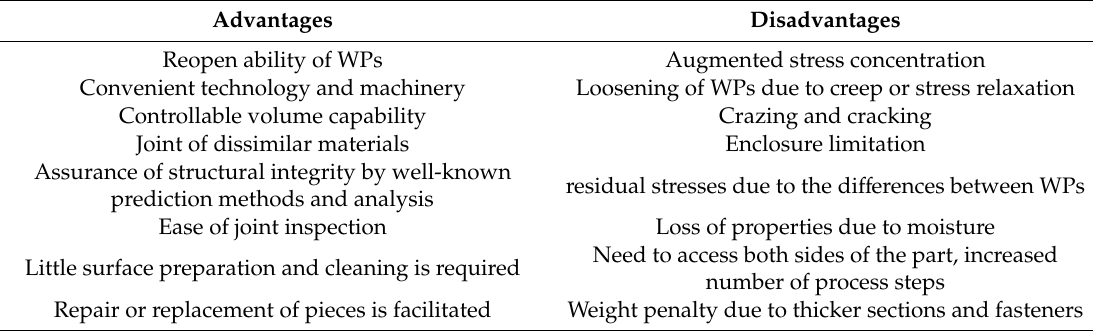
Table 1. Advantages and disadvantages of mechanical